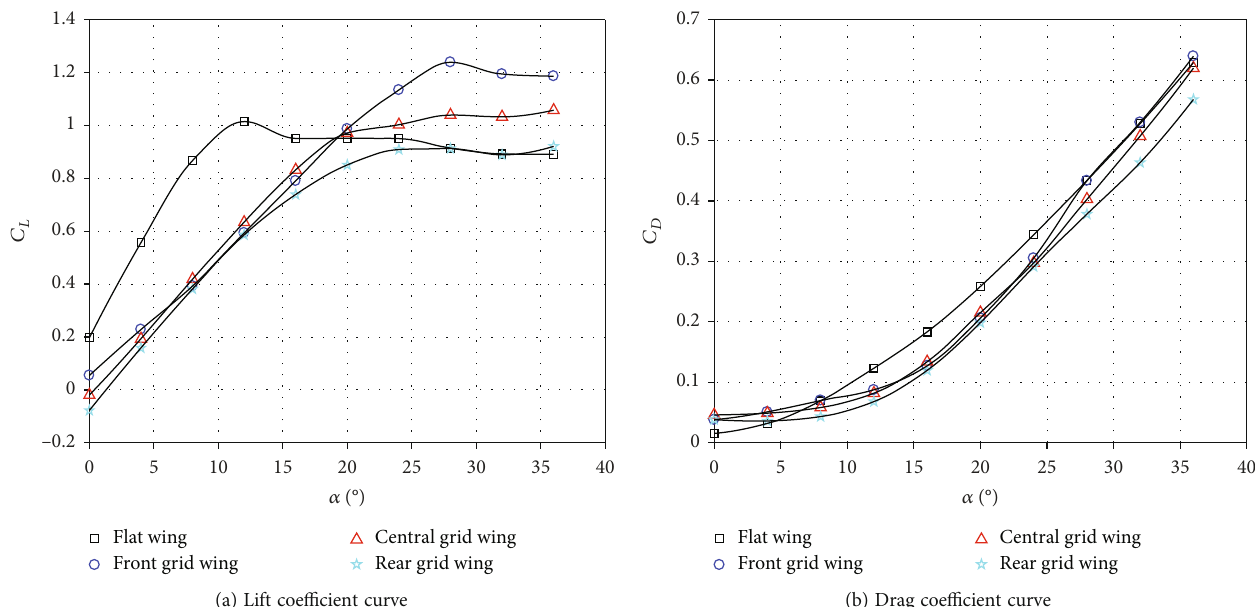
Figure 15: The lift coe ffi cient and drag coe ffi cient curves of the grid fusion lifting surface with di ff erent positions ( Ma = 0 : 6